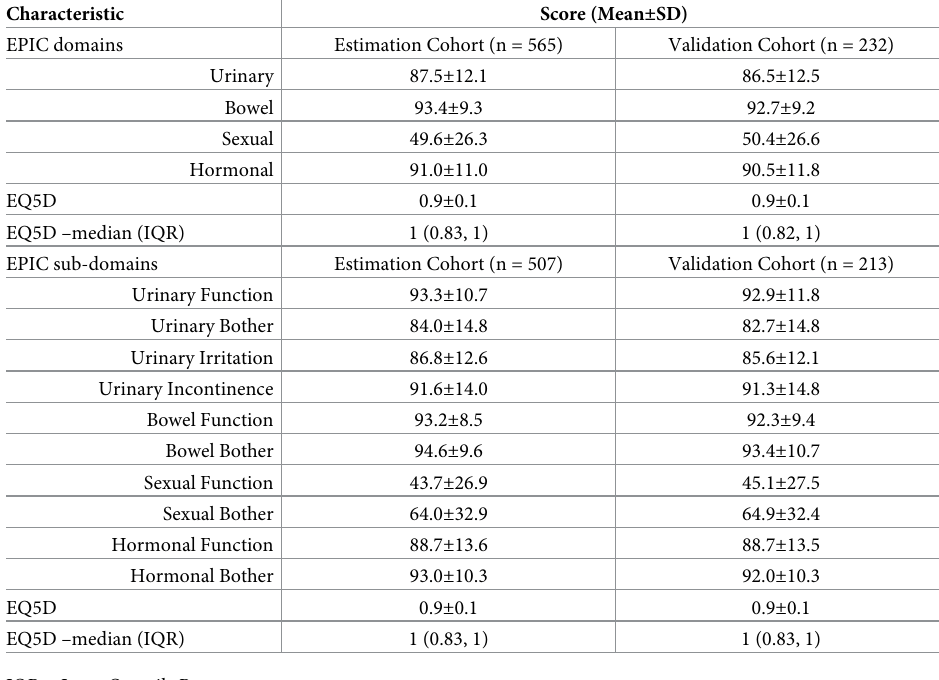
Table 2. EPIC domain and sub-domain scores and EQ5D scores at all study time-points.